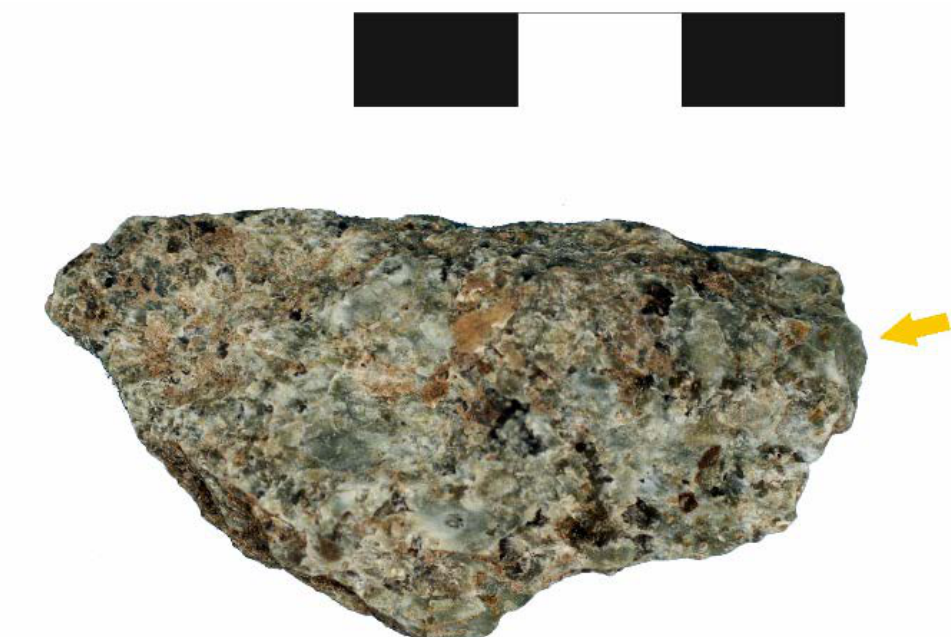
Figure 13. Granite flake from an AVGI I open area (scale in cm). The arrow indicates a partially preserved impact platform.